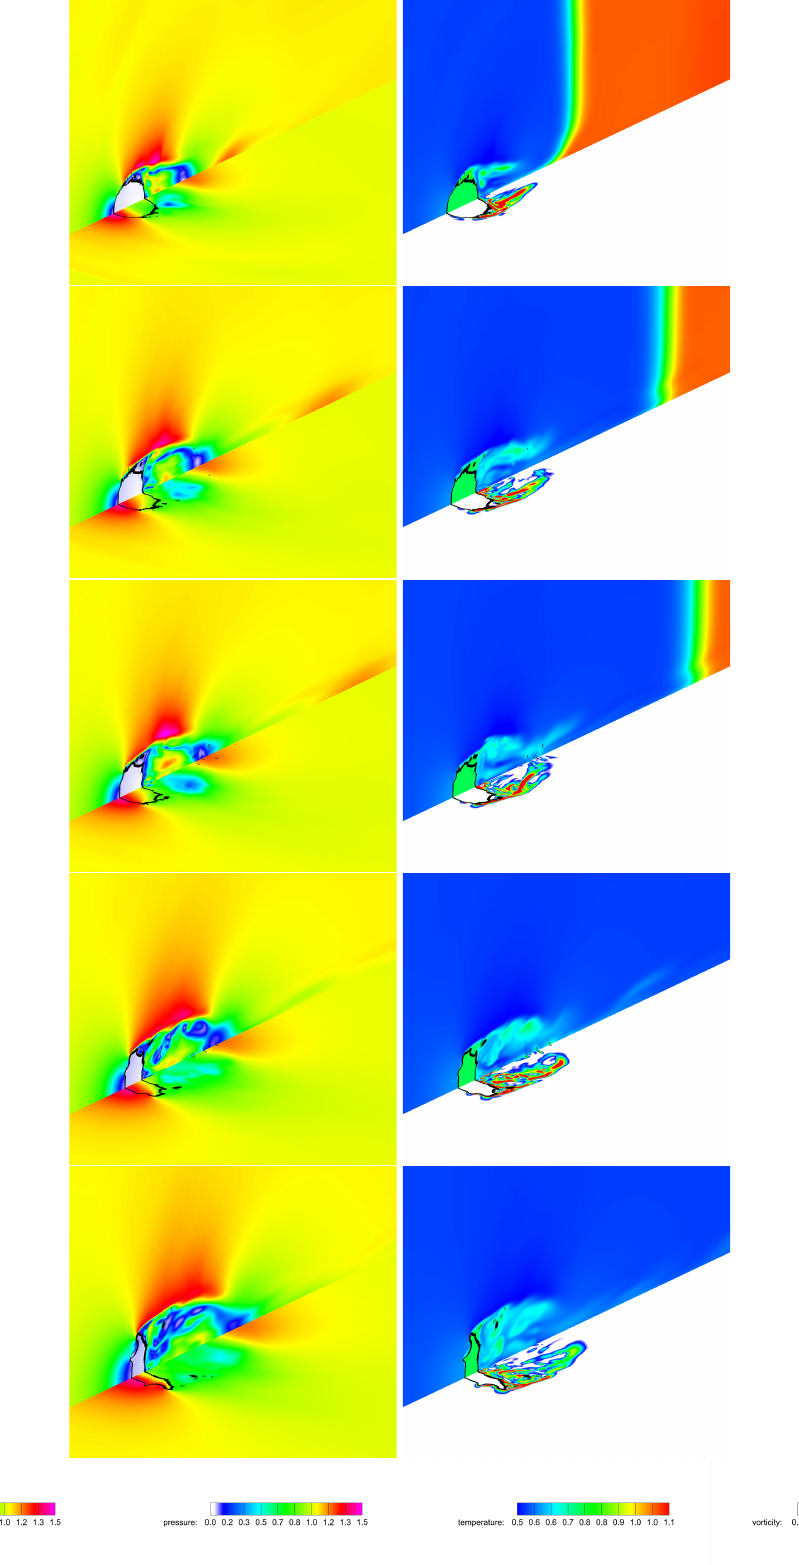
Figure 5. Instantaneous contours for normalized mean flow variables at the midplane x = 0, corresponding to t ∗ = 0.25, 0.35, 0.44, 0.57 and 0.65 (from top to bottom). Vertical planes show speed (left) and temperature (right), while horizontal planes show pressure (left) and vorticity magnitude (right). Main flow is from bottom left to top right